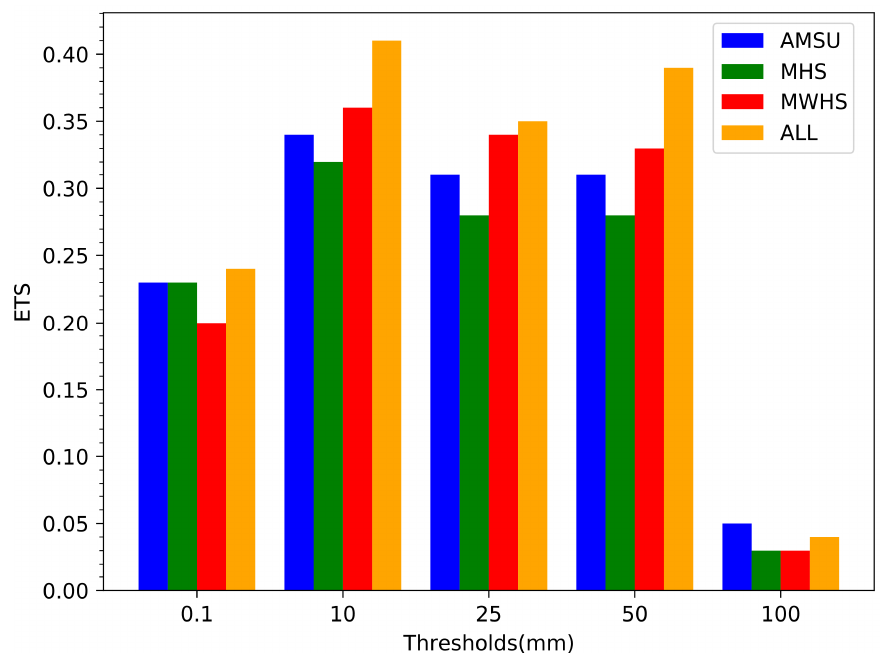
Figure 9. Accumulated 24-h rainfall ETS scores from 0000 UTC on 23 July to 0000 UTC on 24 July 2018.